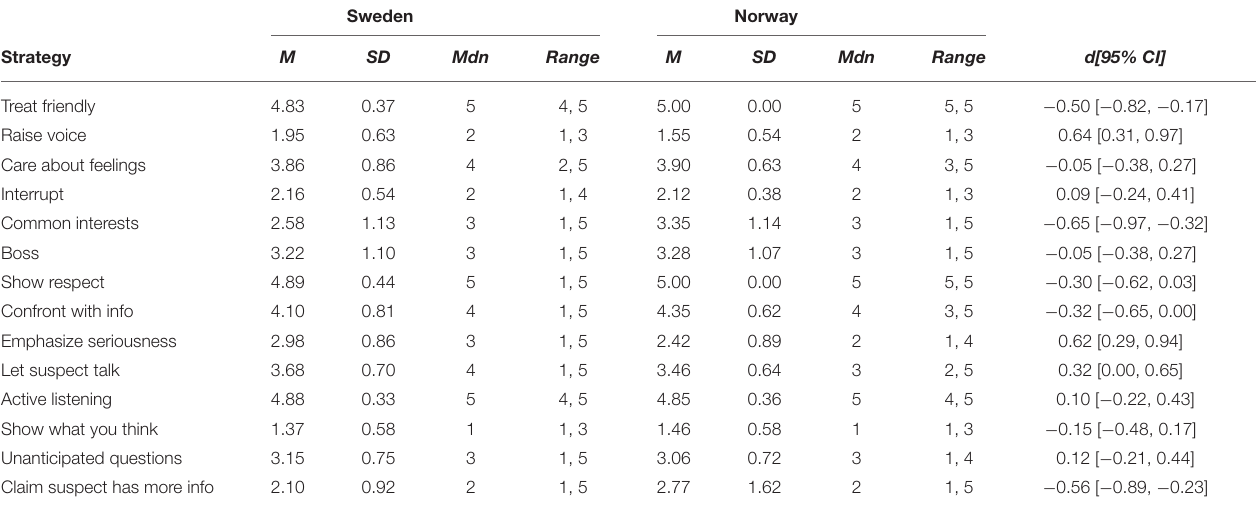
TABLE 3 | Descriptive statistics and sample differences for reported interview tactic usage. Sweden Norway